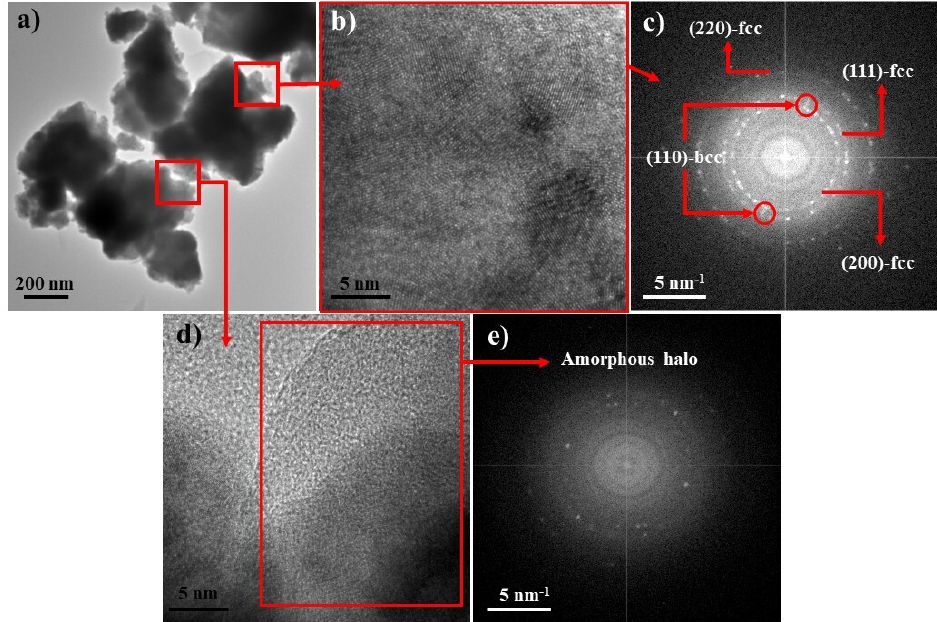
Figure 8. Transmission electron microscopy (TEM) study for theTiNb15Mn alloy milled after 18 h in the 8000D mixer/mill ® (SP10_18h). ( a ) TEM image; ( b , d ) high-resolution TEM images; ( c , e ) the corresponding FFT images. Metals 2021 , 11 , 1225